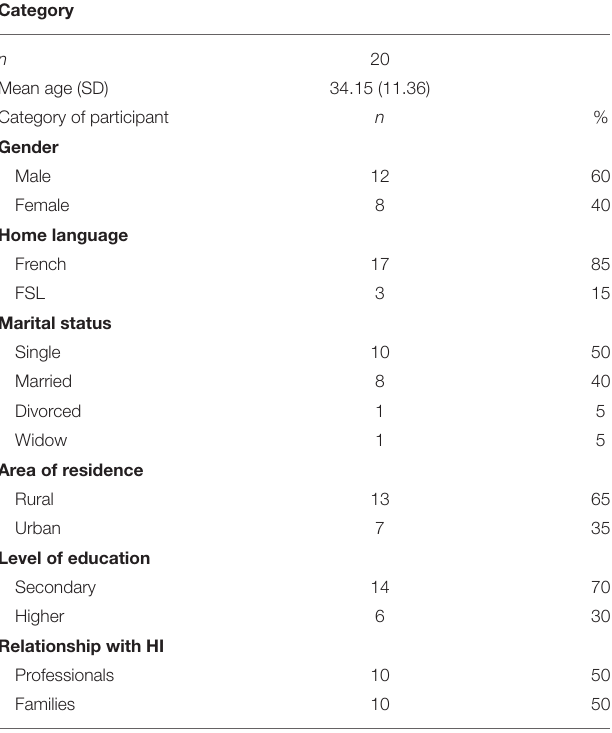
TABLE 1 | Characteristics of